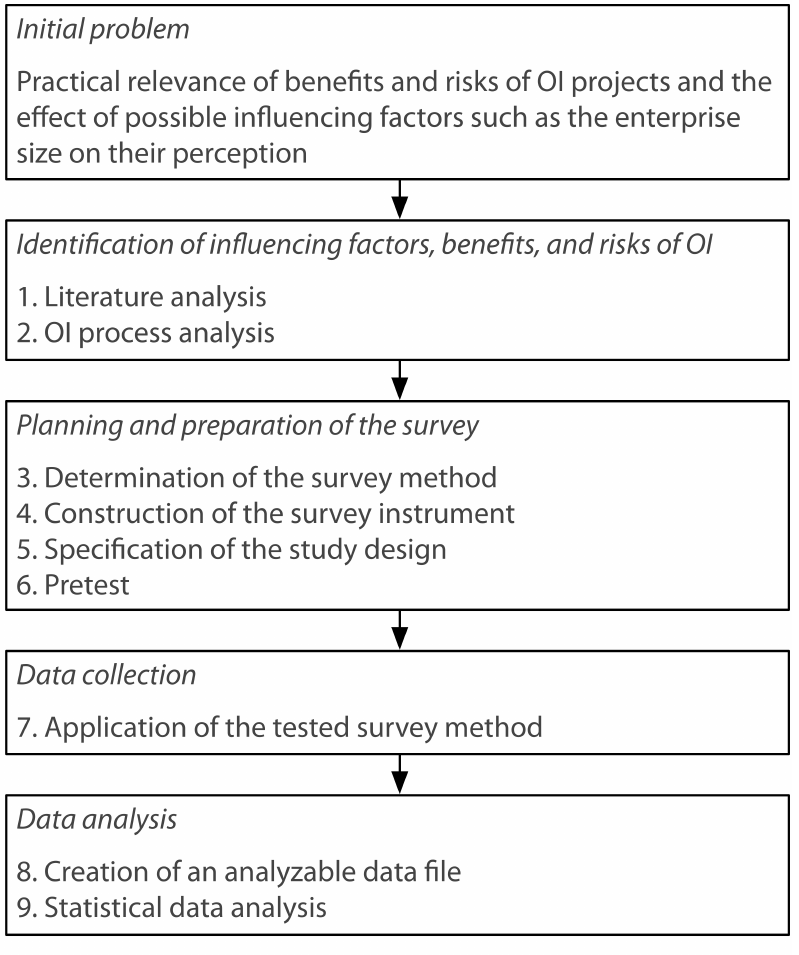
Fig. 2. Methodological approach (following Diekmann, 2012, p.